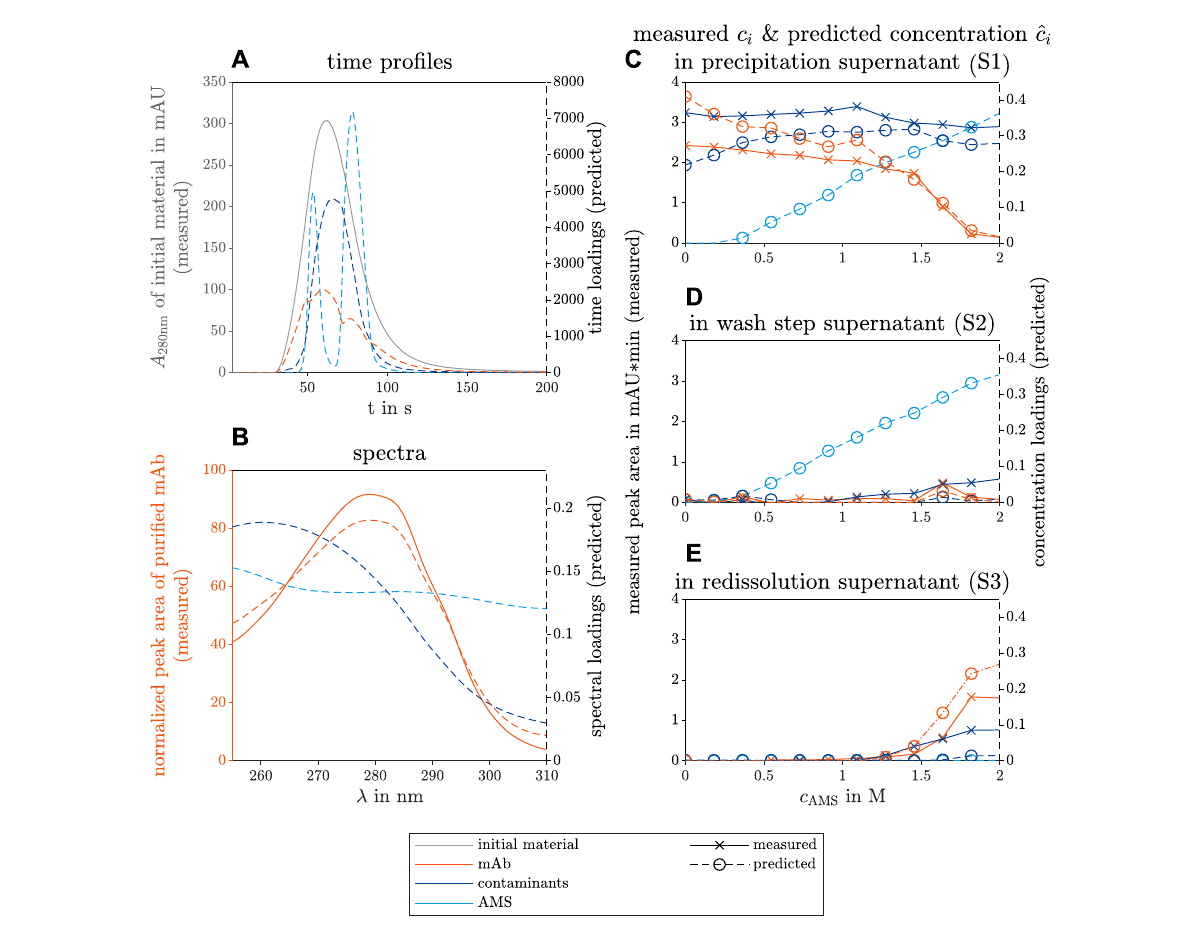
FIGURE 4 PARAFAC model results of the selective mAb precipitation screening from clari fi ed CHO CCS. The measured reference data (left axis) and the predicted loadings (right axis) are illustrated with solid and dashed lines, respectively. The colors gray, orange, dark blue, and light blue indicate the initial raw material, the target mAb, the contaminating species, and the precipitant AMS. The time course loadings in (A) show the PARAFAC model predictions of the species absorption loadings over time t in the fl ow cell of the UV/Vis detector. Additionally, the spectral absorption of the initial solution A 280nm is shown at wavelength 280 nm over time. The spectral loadings in (B) illustrate the predicted contaminant spectrum over the wavelength λ and the similarity between the predicted and the measured mAb spectrum. The predicted concentration loadings ^ c i are shown over varyingprecipitant concentration c AMS during theprecipitation in (C) ,wash step (D) , and redissolution process step (E) .The measured concentration c i is derived from the peak area of the reference analytics. The peak areas of a reference analytic represent the concentrations of the mAb and the contaminant. They are shown in (C – E) with solid